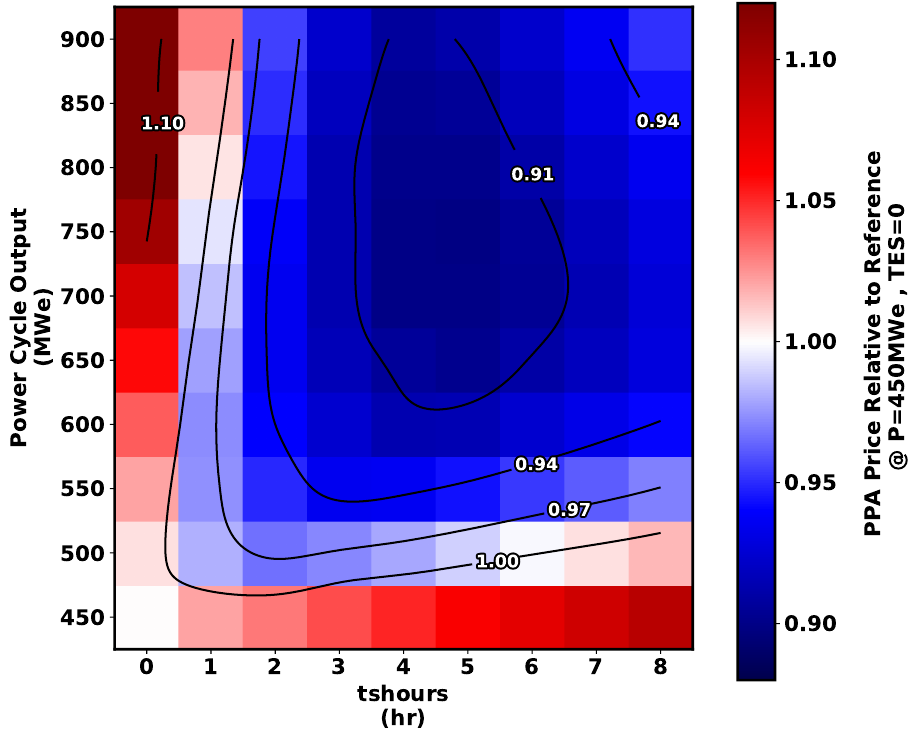
Figure 11. Performance of LFR and TES plant in a simulated CAISO market using normalized price multipliers. Heatmap plots PPA price values relative to the reference design at 450 MW e and 0 h of thermal storage. Contours are generated using interpolated data to highlight key regions: values higher than 1 perform worse than the reference; values lower than 1 perform better. Values higher than 1.1 are not shown for